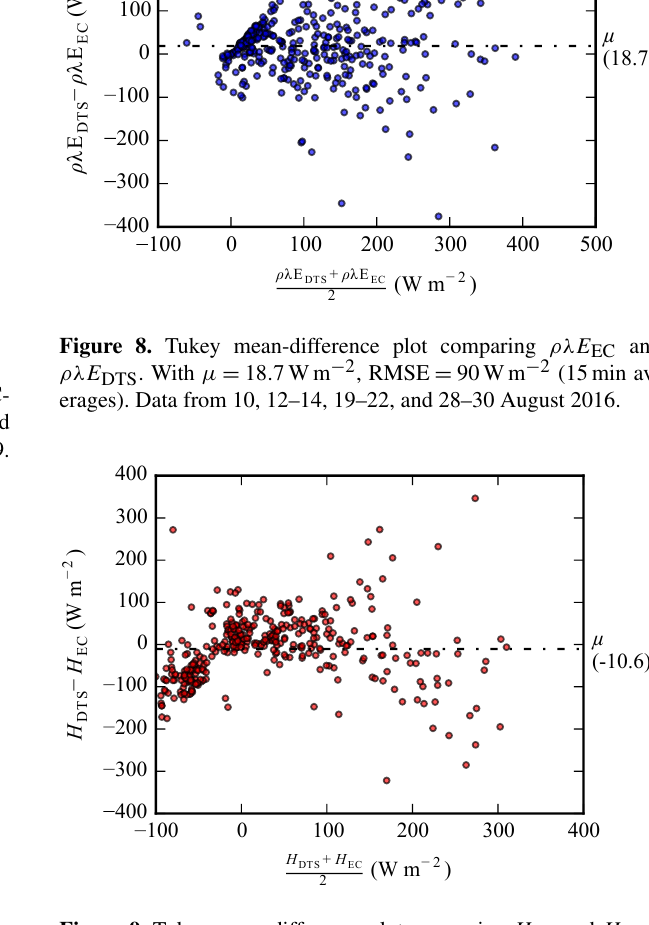
Figure 9. Tukey mean-difference plot comparing H EC and H DTS